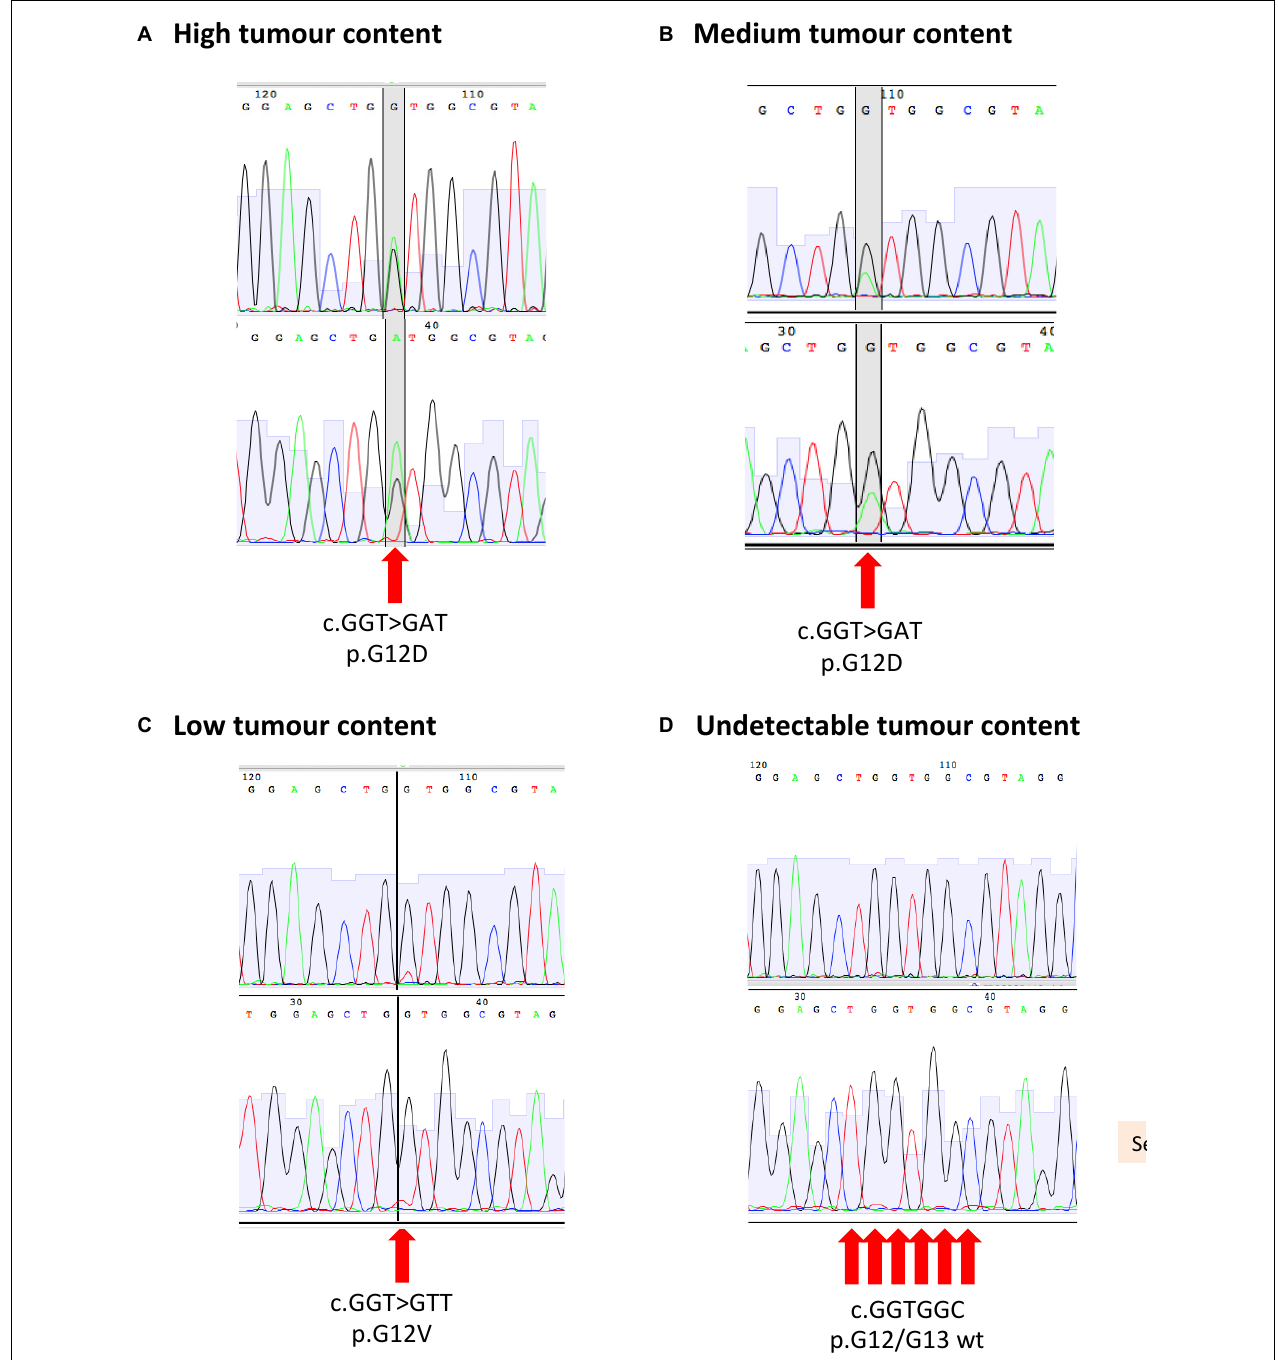
FIGURE 3 | Sanger sequencing for KRAS p.G12/G13 mutation with example of (A) high tumour content, (B) medium tumour content, (C) low tumour content, and (D) undetectable tumour content.